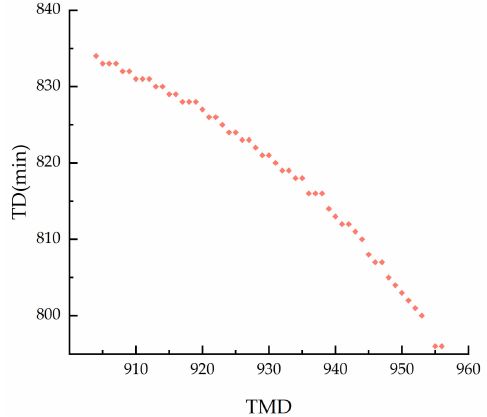
Figure 3. Pareto front of upper-level programming.